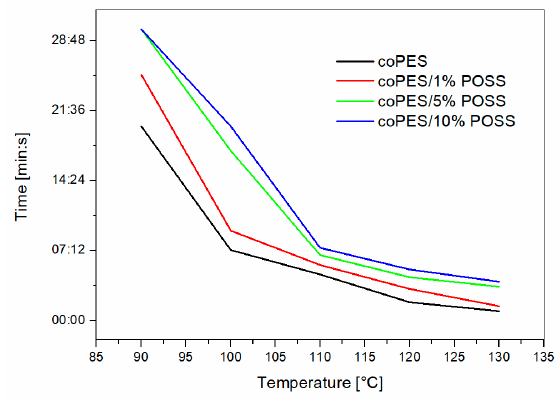
Figure 7. Time to dissolution for different POSS contents as observed by the hot-stage analysis.